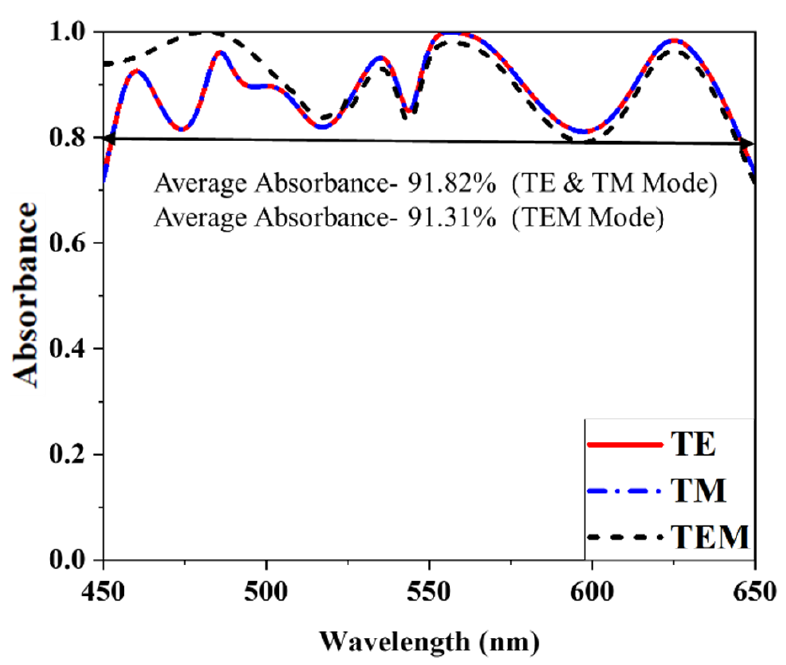
Figure 6. Absorbance characteristics comparison between TE, TM, and TEM modes.